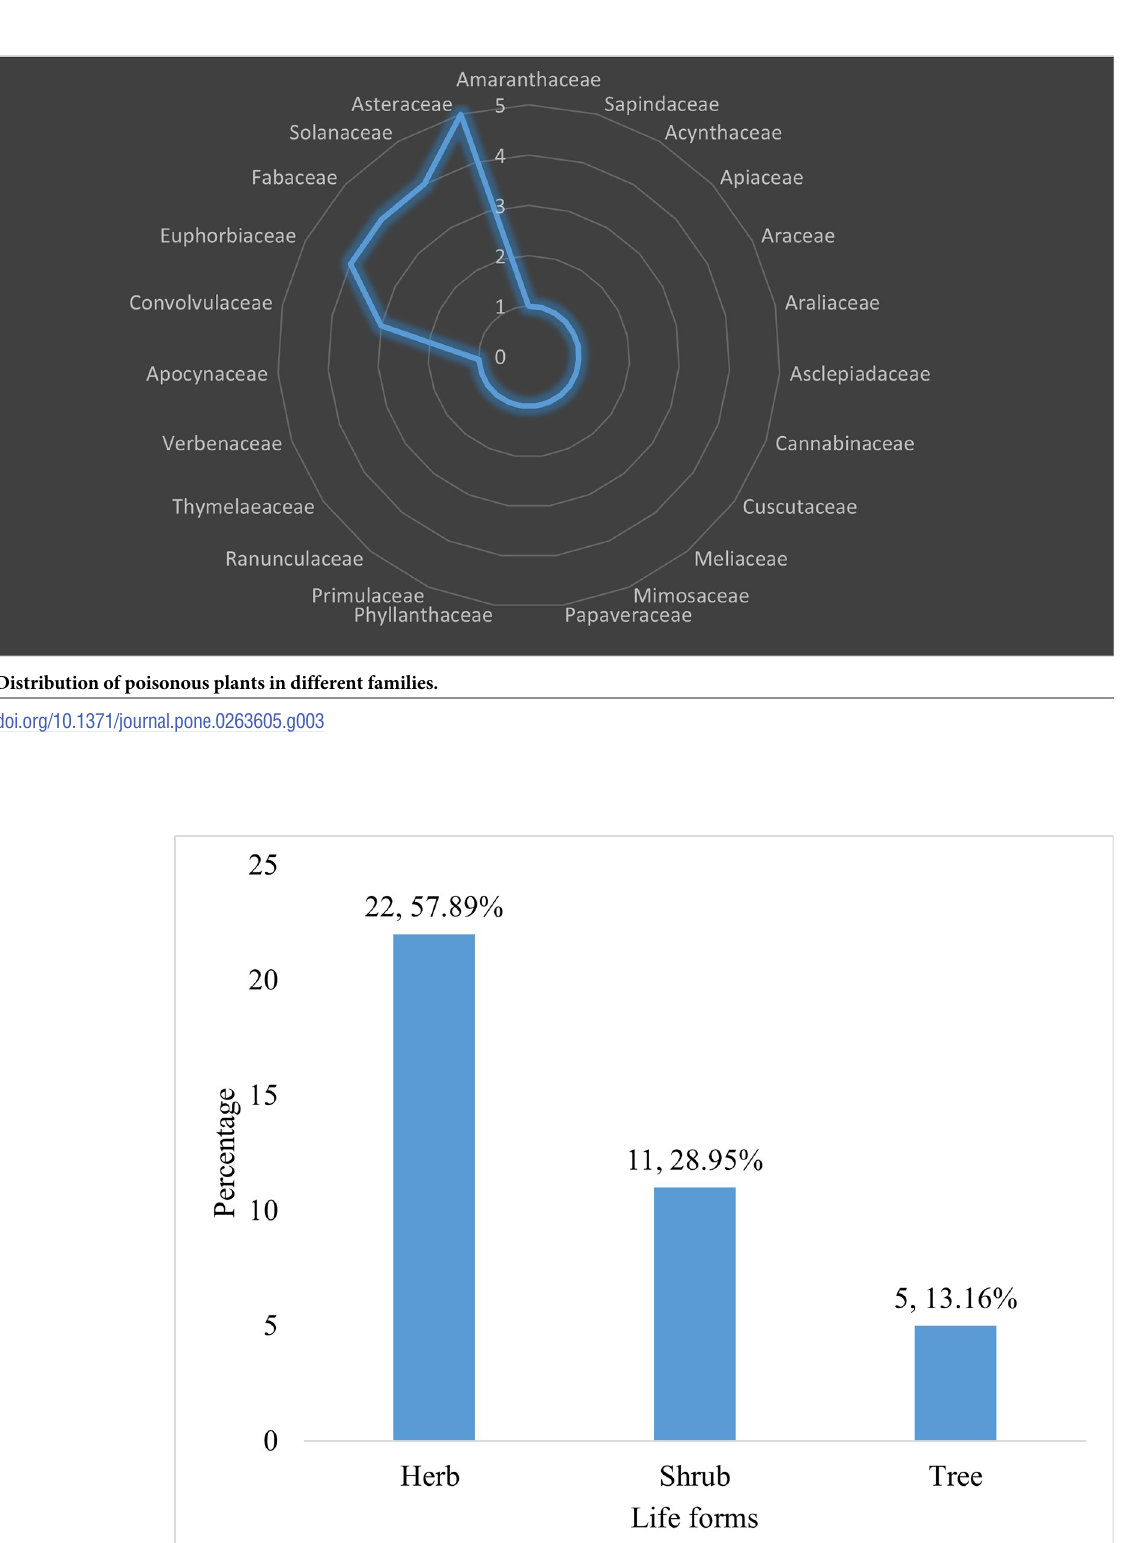
PLOS ONE | https://doi.org/10.1371/journal.pone.0263605 May 11,